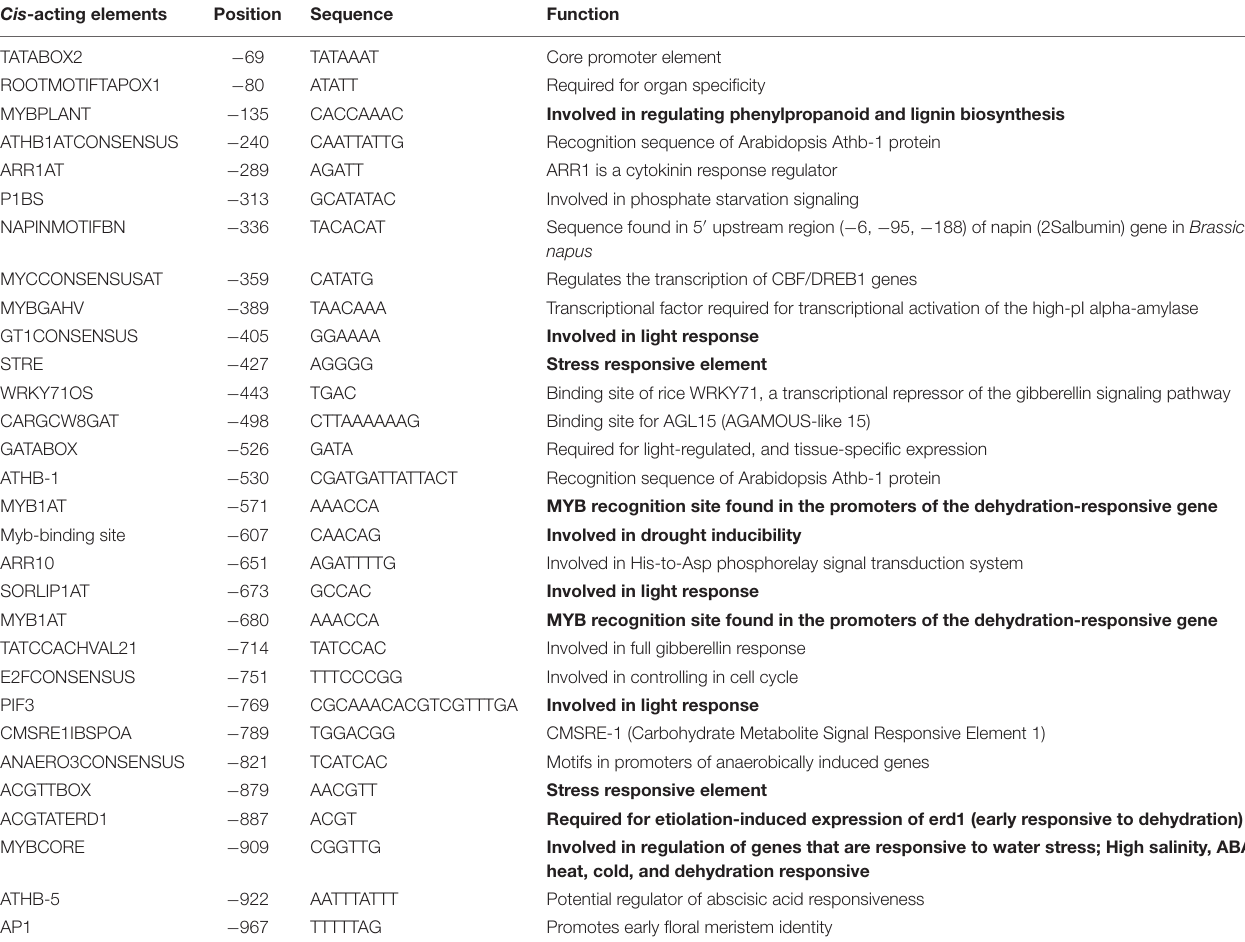
TABLE 1 | Selected cis -acting motifs and their location in the 5 (cid:48) -upstream sequence of ShPLR . Cis -acting